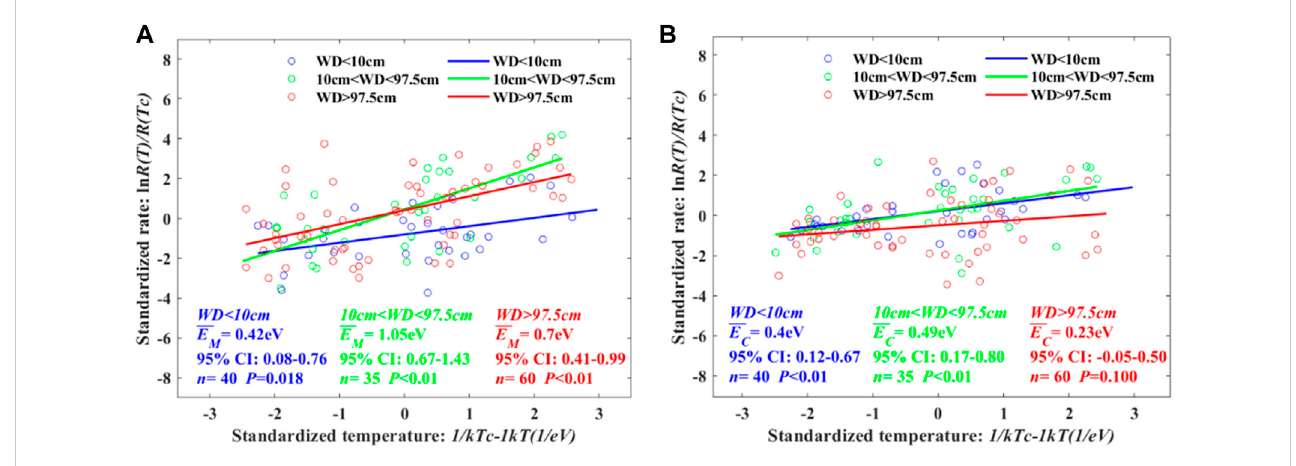
FIGURE 5 Temperature dependence of CH 4 and CO 2 varying with water depth. We evaluated the average temperature dependence at all water depths and separately WD intervals divided by turning points of CH 4 and CO 2 varying with water depth. The temperature independence of CH 4 in WD < 10 cm, 10 cm < WD < 97.5 cm, and WD > 97.5 cm is shown in Figure 5A. The corresponding value of CO 2 is described in Figure 5B.